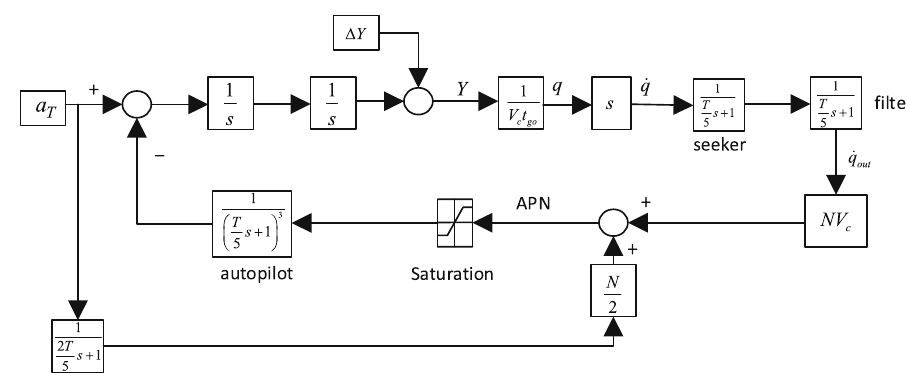
Figure 11: Linearized APN guidance